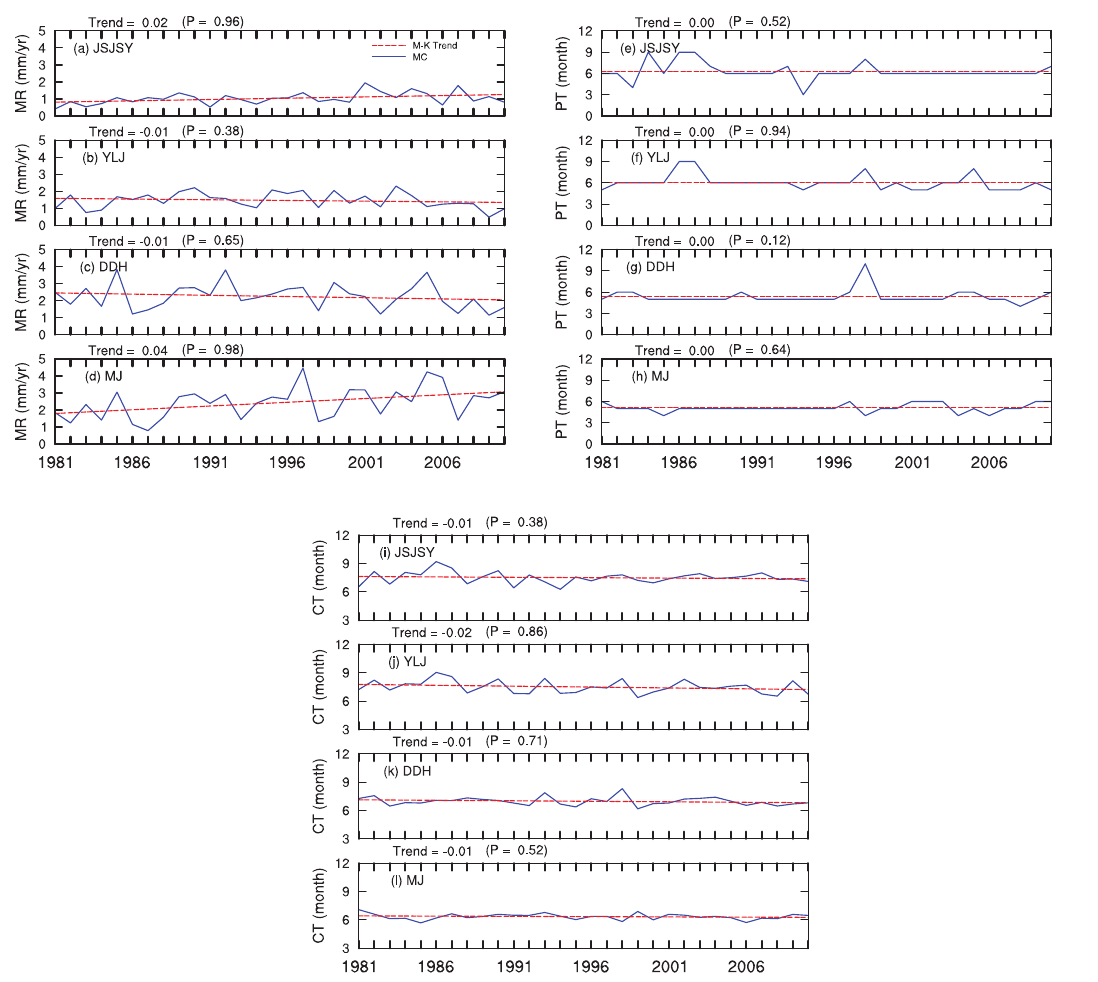
Figure 7. Modeled interannual variation in ( a – d , blue solid line) melt runoff (MR, mm/year), ( e – h , blue solid line) the peak time of MR (PT, month), and ( i – l , blue solid line) the center of MCR (CT, month) in the 4 sub-regions (JSJSY, YLJ, DDH, and MJ) with the most notable MCR values from 1981 to 2010. The Mann-Kendall (M-K) trend calculated for MR ( a – d , red dashed line), PT ( e – h , red dashed line), and CT ( i – l , red dashed line) are also shown, and the Theil-Sen trend estimator (Trend) and coresponding M-K trend significance ( P ) are listed above each